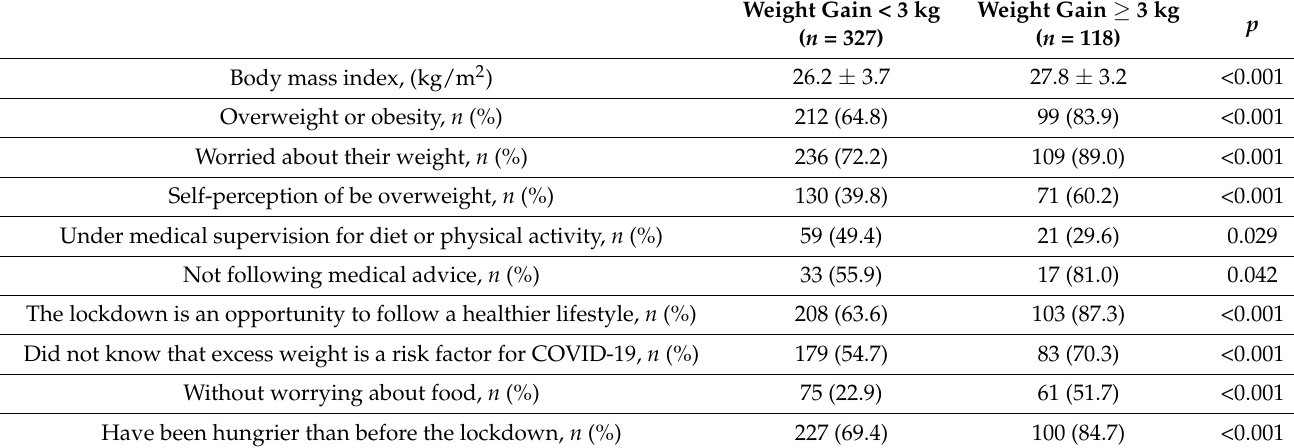
Table 3. Significant differences in respondents who self-reported weight gain according to the amount of weight